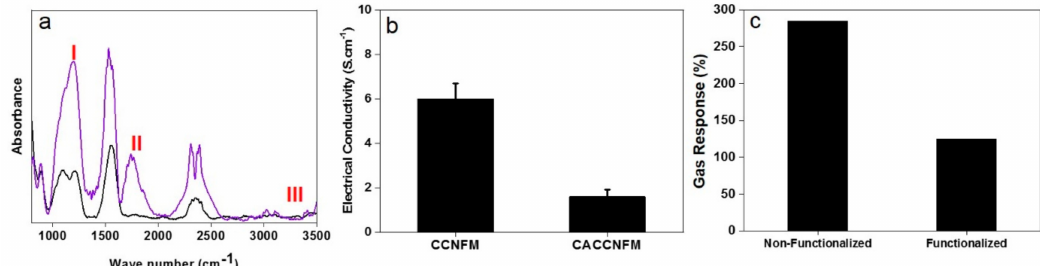
Figure 5. ( a ) ATR-FTIR showing the surface chemistry of a-CO x / G nanofilaments as non-functionalized (black line) versus citric acid (CA)-functionalized (blue line) (I, II, and III represent C-O-C, C = O, and OH groups, respectively); ( b ) electrical conductivity of the carbon nanofilament-based membrane (buckypaper) as non-functionalized versus CA-functionalized; ( c ) toluene gas response of the a-CO x / G buckypapers as CA-functionalized and